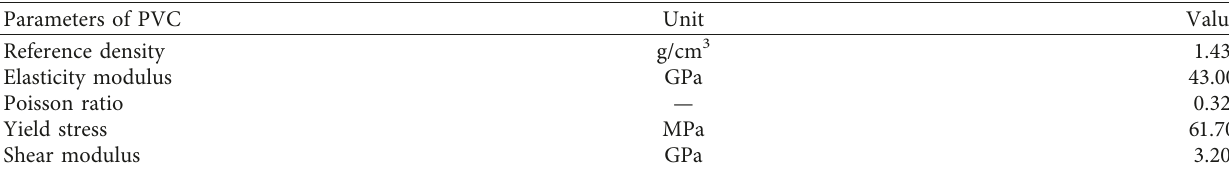
Table 3: Cumulative tube mechanical